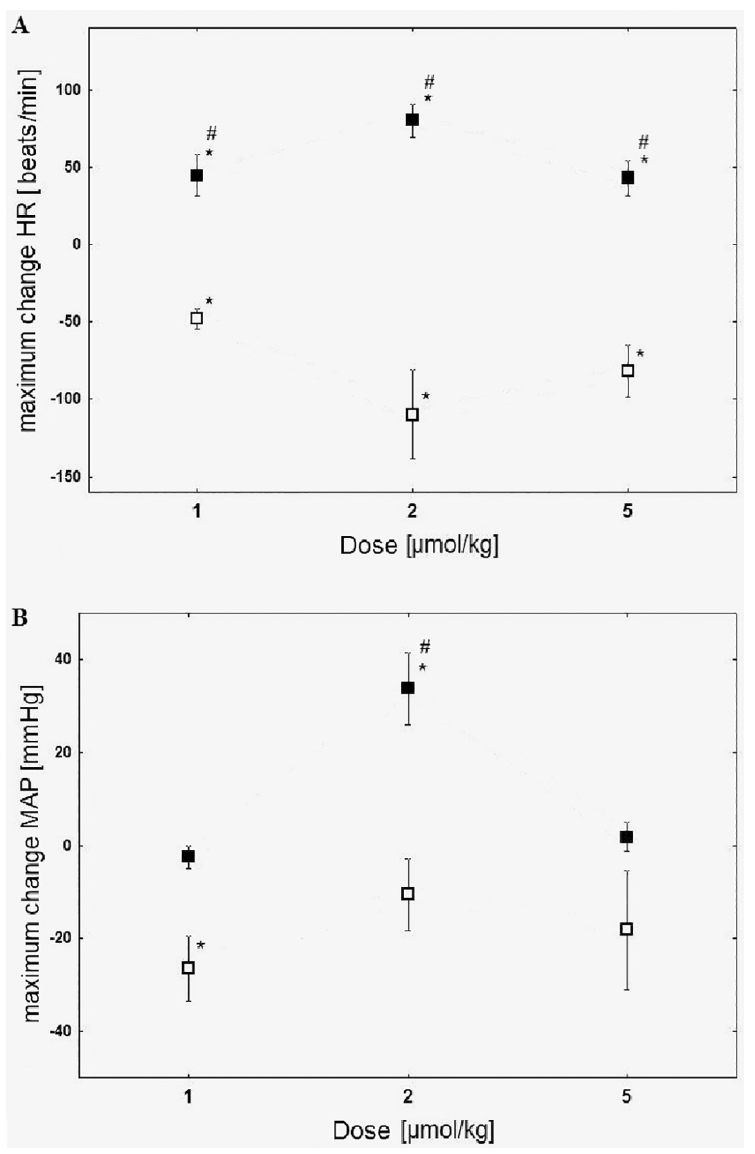
Fig 1. Maximum changes of heart rate (HR) (A) and mean arterial pressure (MAP) (B) post intravenous clobenpropit injection (1, 2 and 5 μmol/kg) in normotensive rats ( □ ) and in critical hemorrhagic hypotension ( ■ ); n = 5; medium ± SEM; (cid:3) p < 0.05 compared to initial values; #p < 0.05 compared to the normotensive animals